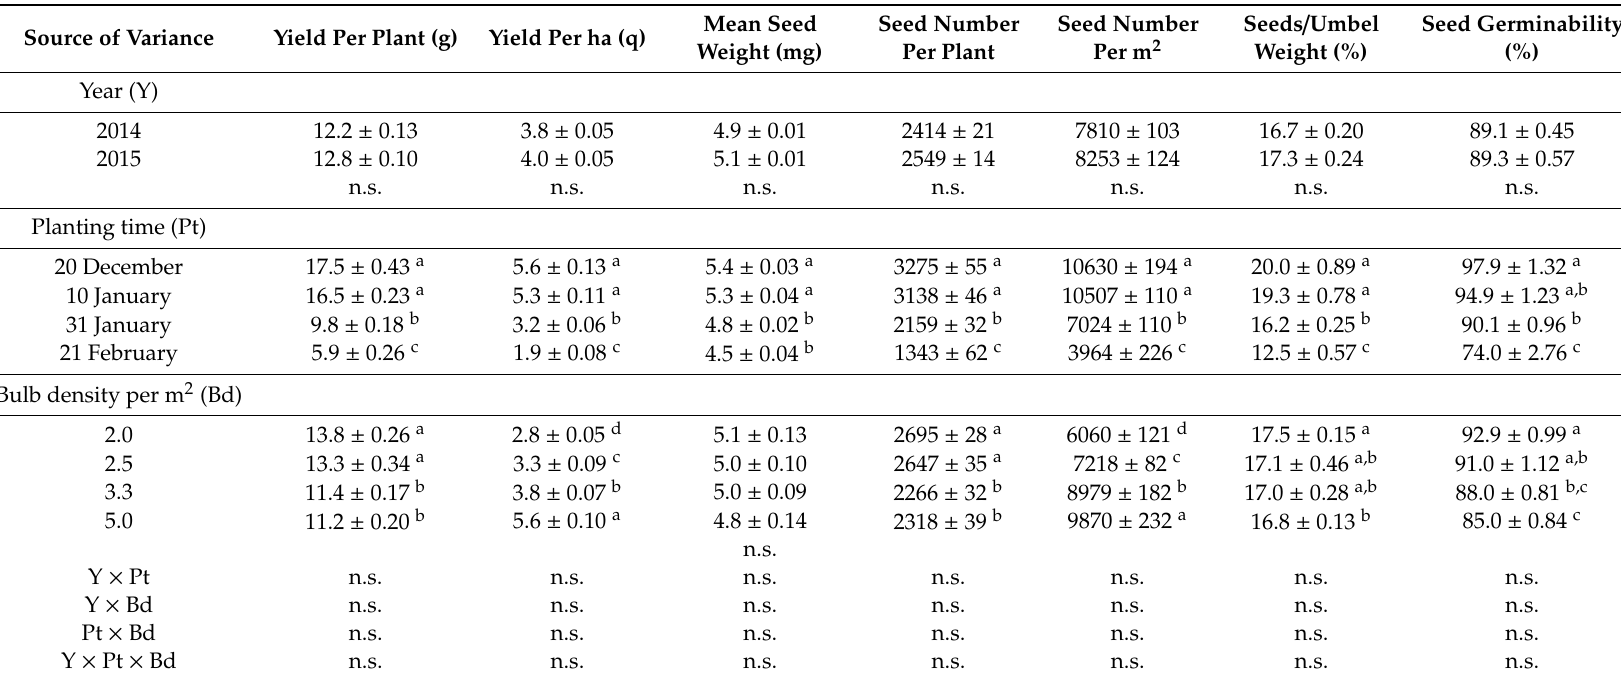
Table 3. Mean values of yield parameters and germinability of onion seeds as a ff ected by bulb planting time and density (n = 3 ± SD). Source of